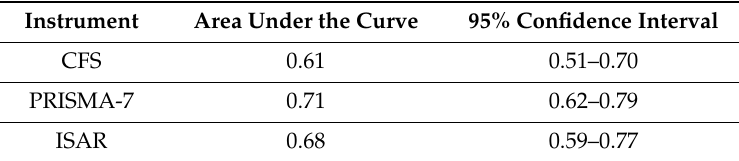
Figure 2. Receiver operating characteristic curves with area under the curve scores showing the accuracy of the Clinical Frailty Scale (CFS), Programme of Research to Integrate Services for the Maintenance of Autonomy 7 (PRISMA-7) tool, and the Identification of Seniors at Risk (ISAR) tool in di ff erentiating frailty from pre-frailty (classification based on the FRAIL scale ). Table 2. Diagnostic accuracy based on the area under the curve (AUC) values with 95% confidence intervals (CI) for the Clinical Frailty Scale (CFS), Programme of Research to Integrate Services for the Maintenance of Autonomy 7 (PRISMA-7) tool, and the Identification of Seniors at Risk (ISAR) tool for separating frail and non-frail based on (1) the comprehensive geriatric assessment (CGA), (2) FRAIL scale, and (3) Groningen Frailty Indicator (GFI) frailty classification